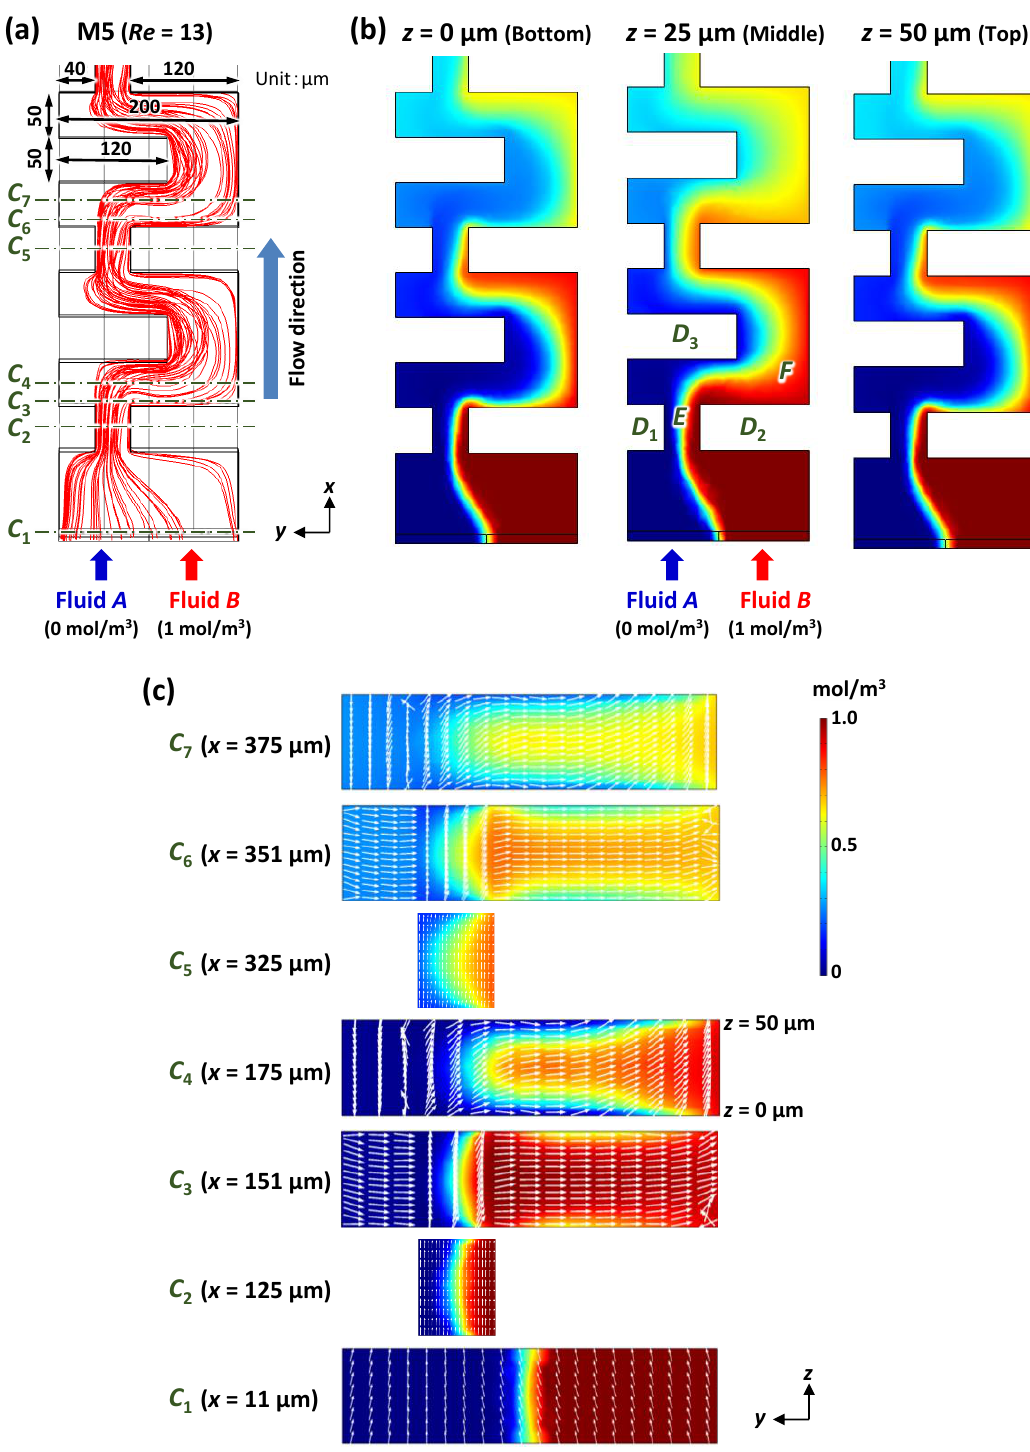
Figure 12. Simulation results showing ( a ) the flow streamlines, ( b ) the concentration contours of two different fluids (with a concentration of 0 and 1 mol/m 3 ) on the bottom surface ( z = 0), middle surface ( z = 25 µm), and top surface ( z = 50 µm) of the microchannel in the asymmetric micromixers (M5) at a flow velocity of 8.3 × 10 –2 m/s each (equivalent to a total flow rate of 100 µL/min and Re = 13), and ( c ) the concentration distribution (contour) and transverse velocity fields (arrows) across the microchannel cross-section at different x positions ( x = 11–375 µm).